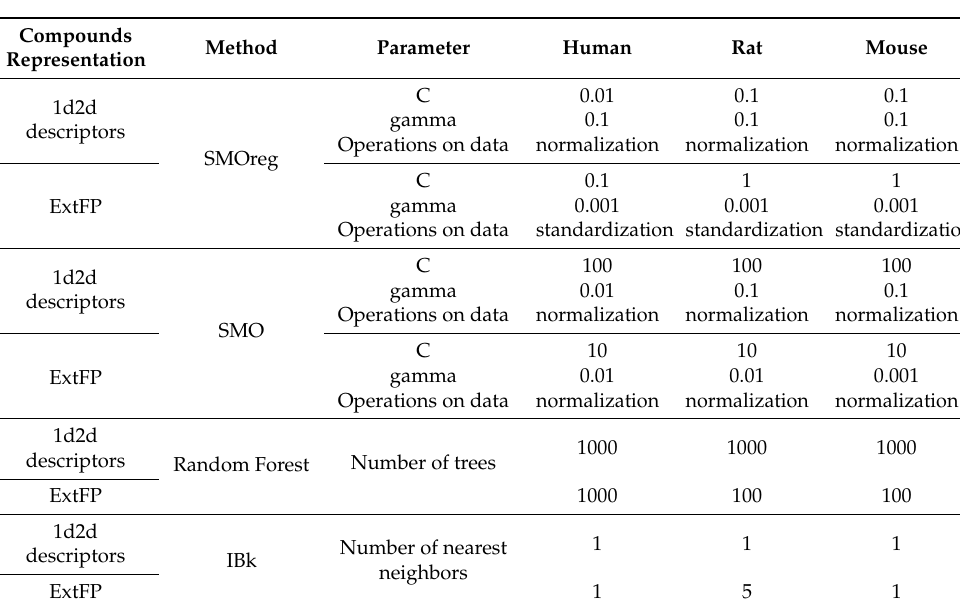
Table 7. Conditions selected for each